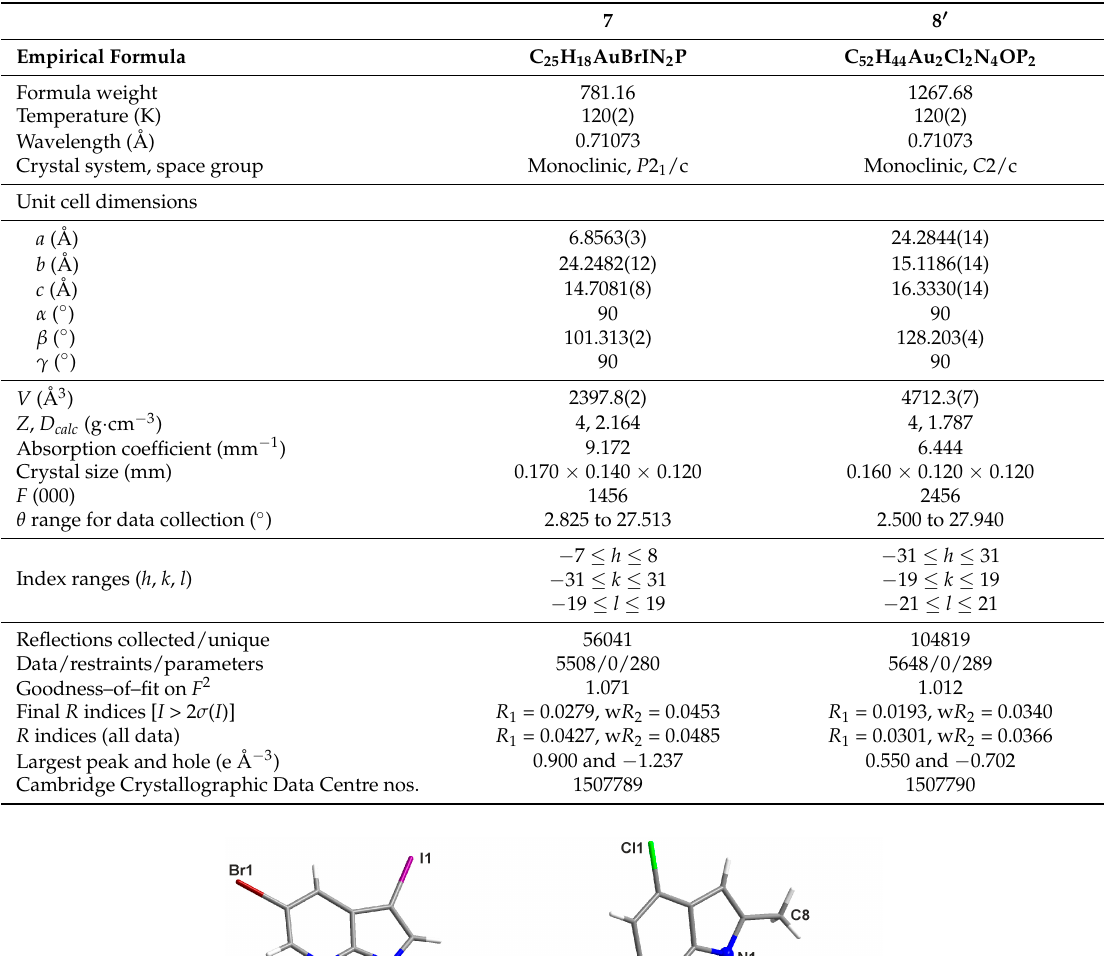
Table 1. Crystal data and structure refinements for the complexes [Au( 3I5Br aza)(PPh 3 )] ( 7 ) and